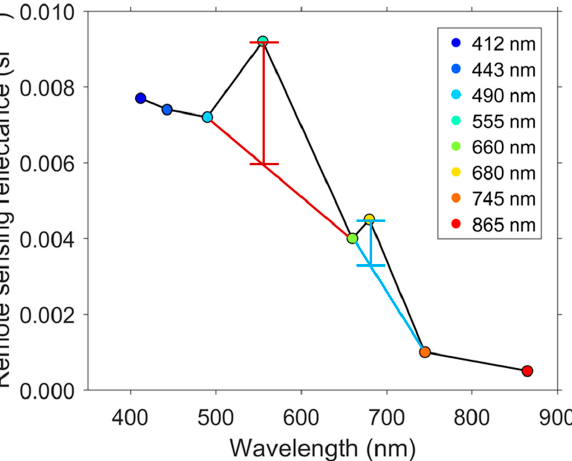
Figure 6. Spectral distribution of remote sensing reflectance with bimodal peaks at GOCI spectral bands from 412 to 865 nm, where red and blue lines show how to calculate the bimodal peak heights in the red tide index algorithm. Remote Sens. 2021 , 13 , x FOR PEER REVIEW